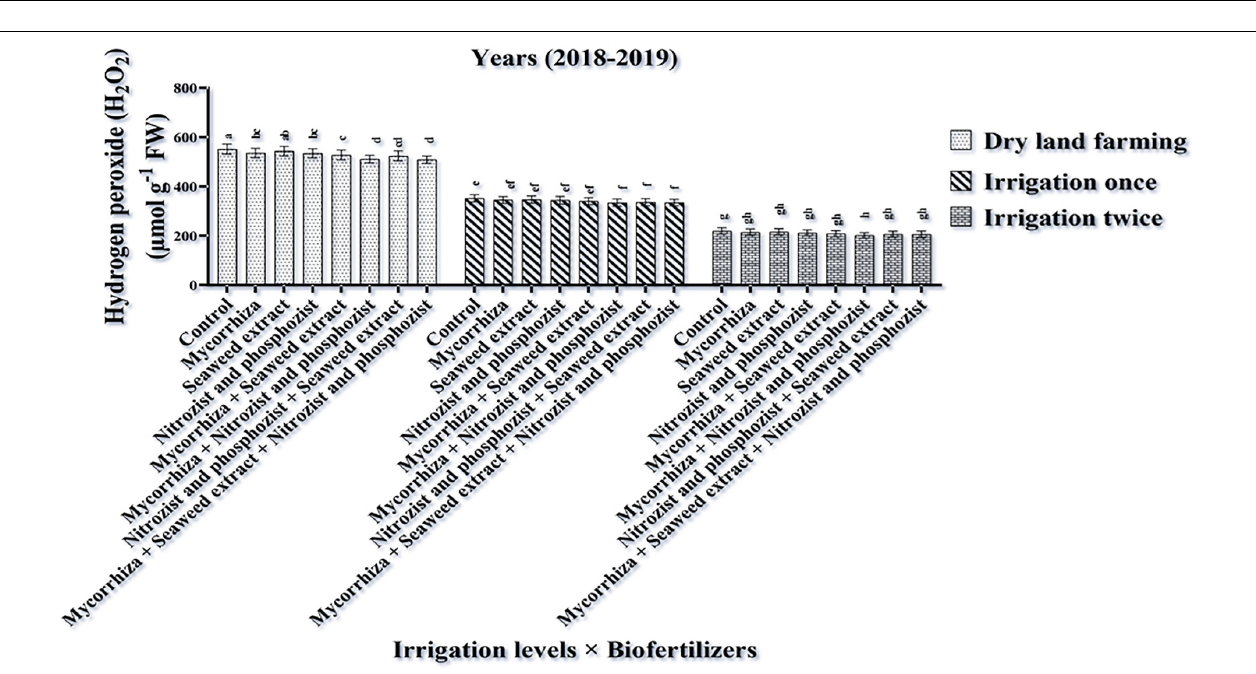
FIGURE 6 | Mean comparisons of the dual interaction effect of irrigation × biofertilizers on hydrogen peroxide content in wheat plant in 2018–2019. Means in each column followed by similar letter(s) are not significantly different at 1% probability level by the LSD test.